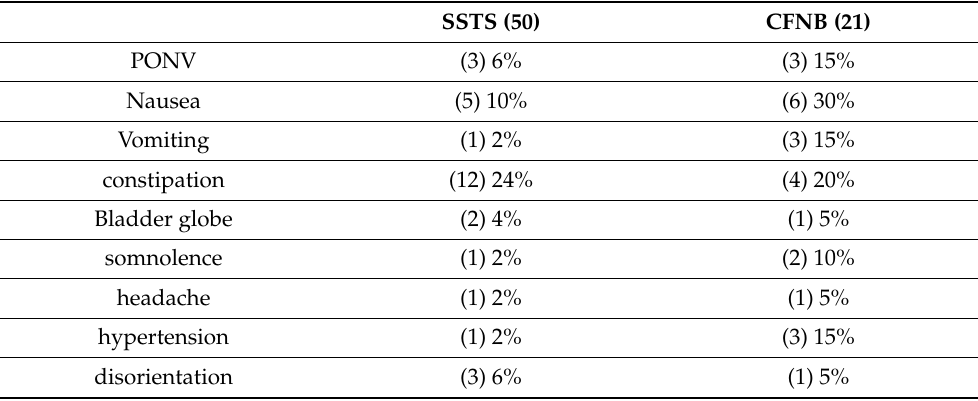
Table 1. Adverse events reported in the SSTS group vs. cFNB